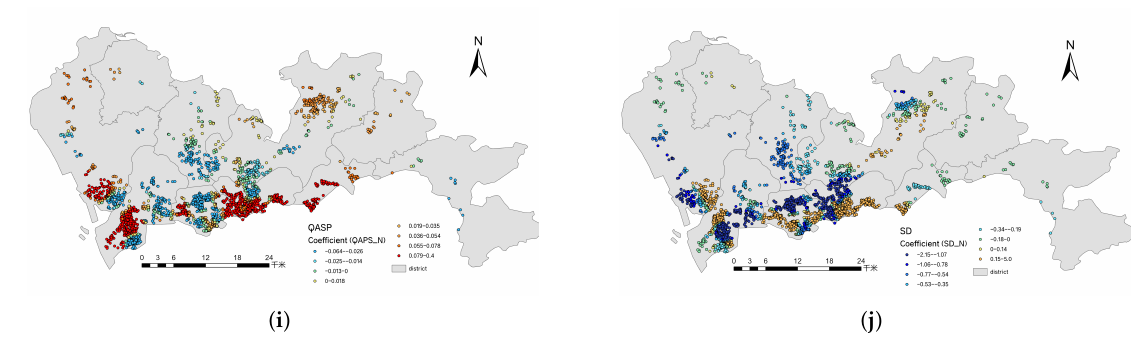
( i ) ( j ) Figure A1. Coefficient Weight Distributions of Variables for GWR model. ( a ) Intercept; ( b ) Age of Building (AB); ( c ) Distance to the Nearest Subway Station (DSS); ( d ) Green Ratio (GR); ( e ) Manage- ment Fee (MF); ( f ) Number of Parking Spots (NPS); ( g ) Number of Subway Stations within 1 km radius (NSS); ( h ) Plot Ratio (PR); ( i ) Quality of Available Public Schools (QAPS); ( j ) Sea Distance